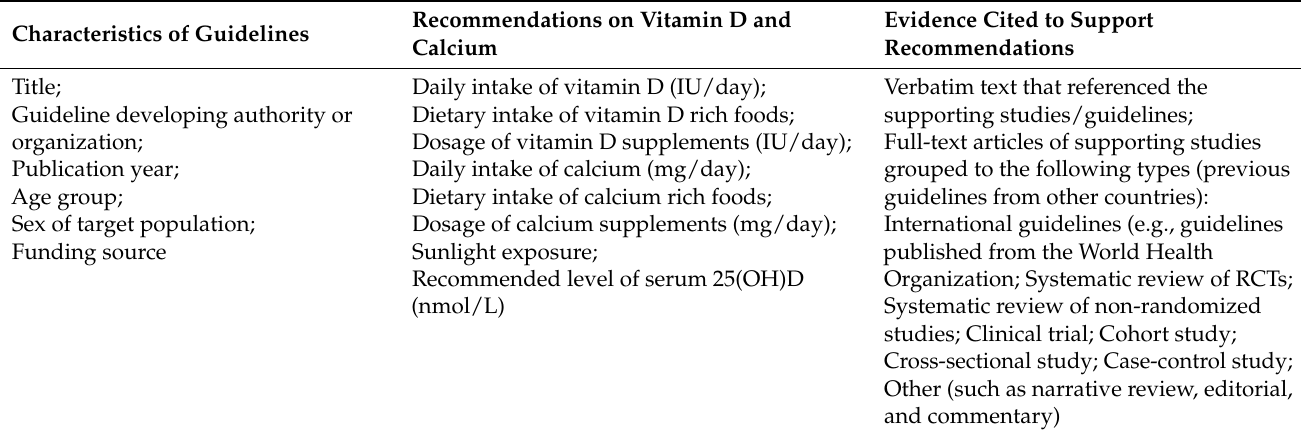
Table 1. Data items extracted from